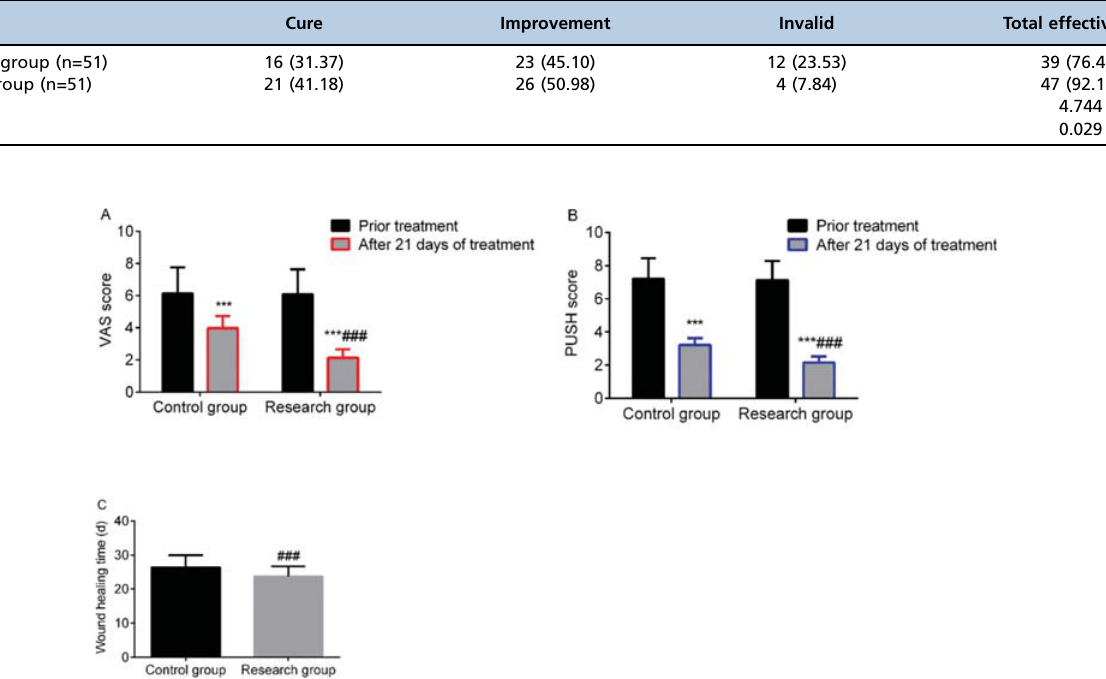
Table 2 - Comparison of treatment efficacy between the two groups (n (%)).